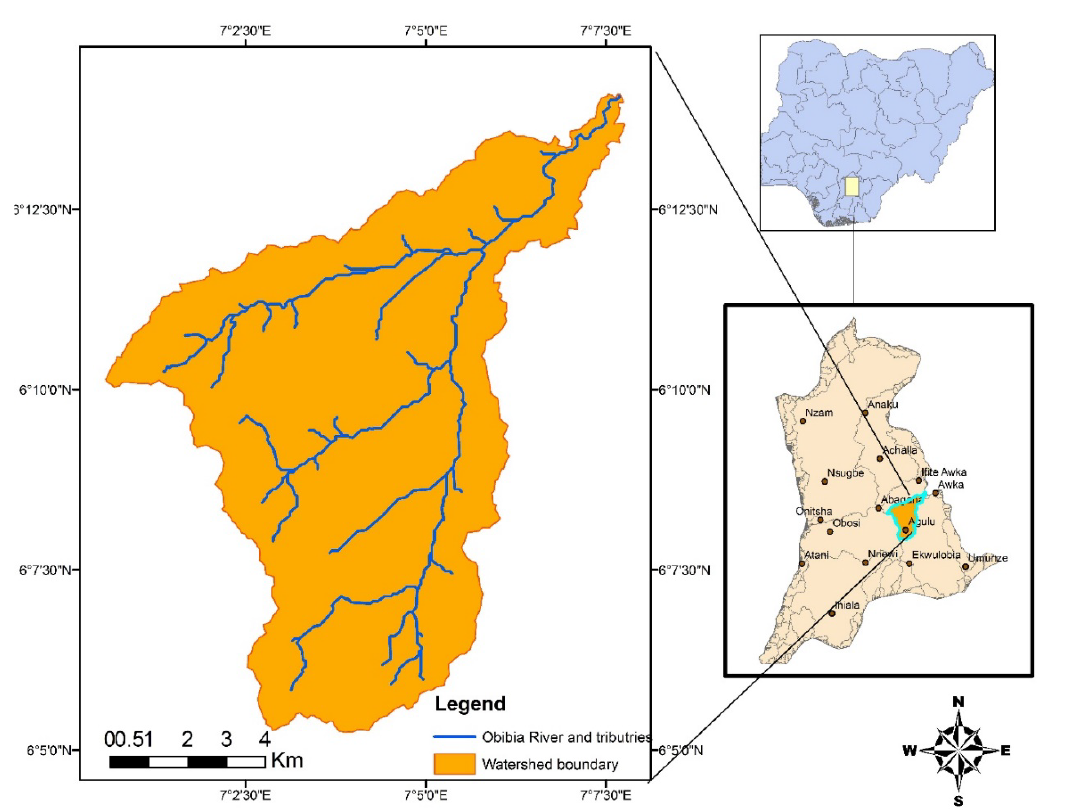
Figure 1. The study area of Obibia River watershed, Anambra, Nigeria, and its general